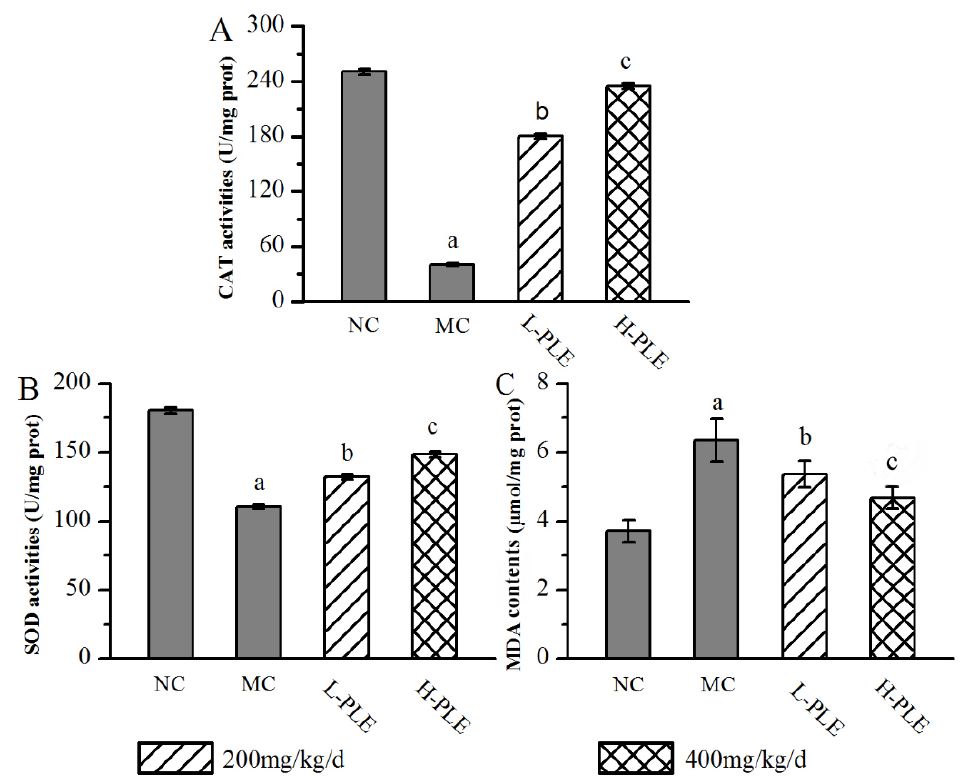
Figure 4. Effects of PLE on antioxidant status in zymosan-induced ALI mice. ( A ) CAT activities, ( B )